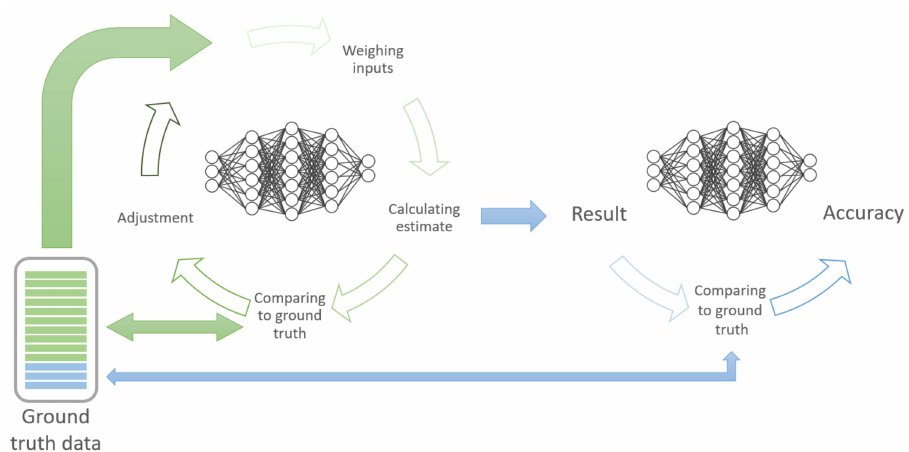
Figure 4. Concept of training (green) and testing/validating (blue) ML